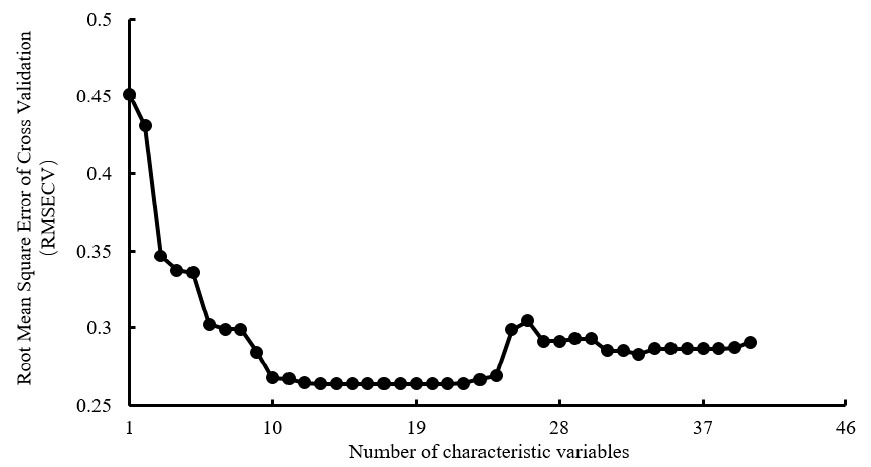
Figure 8. VISSA variable selection results based on image shape, size, color, and texture information.